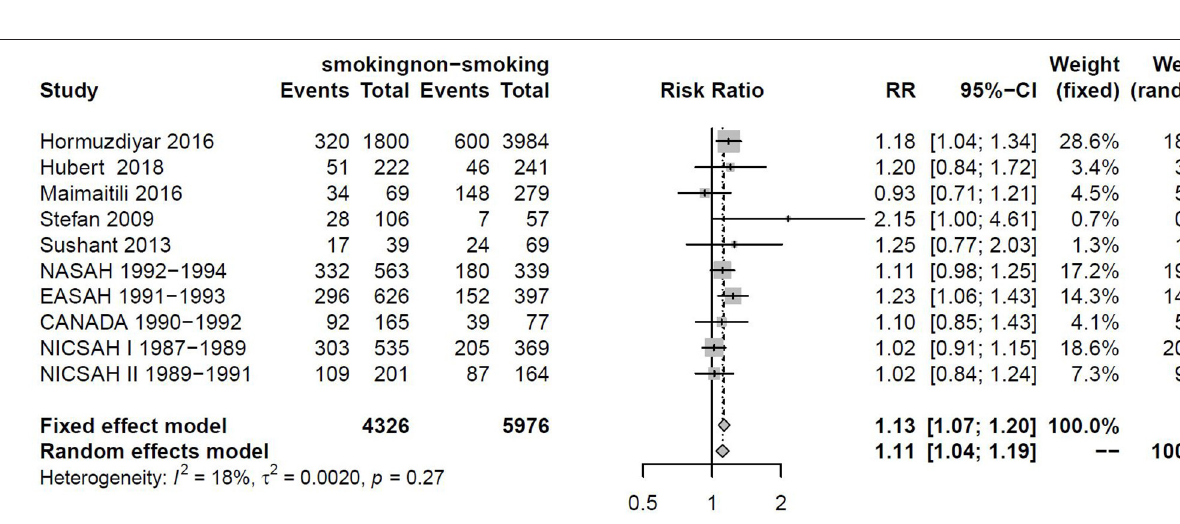
is a need to correct the asymmetry of the funnel